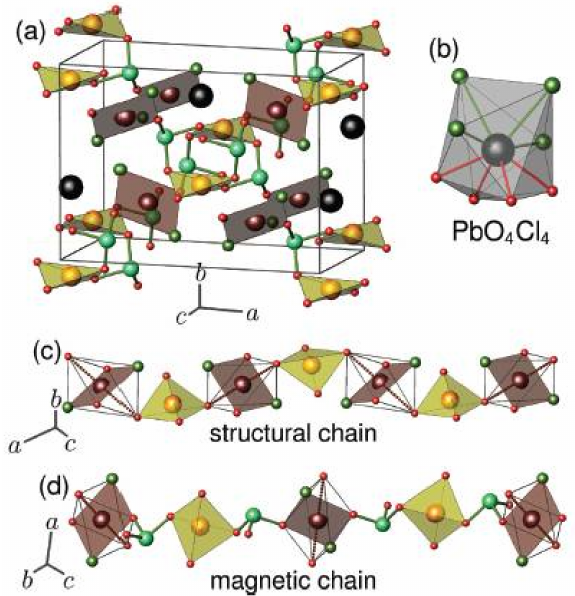
Figure 10. Crystal structure of PbCu 2 (SeO 3 ) 2 Cl 2 . ( a ) The unit cell. Magnetic Cu(1)O 4 and Cu(2)O 2 Cl 2 plaquettes are shown as light and dark filled polyhedra. Se–O bonds and Pb atoms are denoted by lines and large black spheres, respectively. ( b ) The coordination polyhedron of Pb. ( c ) Structural chains, formed by cornersharing Cu(1)O 4 distorted plaquettes and Cu(2)O 4 Cl 2 octahedra (empty octahedra, with filled Cu(2)O 2 Cl 2 plaquettes; long Cu(2)-O contacts are shown with thick dashed lines). ( d ) Magnetic chains. The nearest-neighbor superexchange J 1 runs via Cu(1)–O · · · O–Cu(2) paths, along the edge of a SeO 3 pyramid (Se–O bonds are shown with lines). Reproduced from Ref. [29] with permission from the Royal Society of